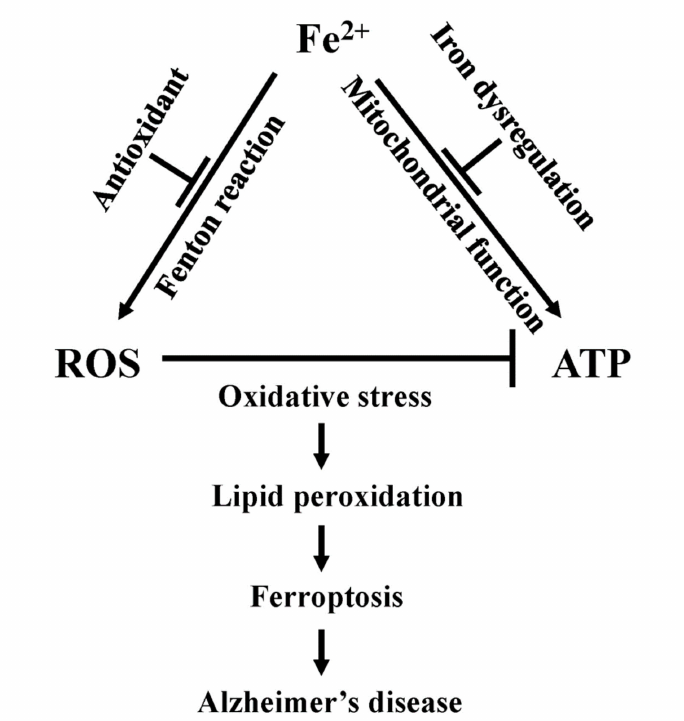
Figure 5. Ferroptosis, mitochondrial dysfunction and Alzheimer’s disease. Unbound Fe 2+ plays a role in ATP production via electron transfer and enzymatic reactions [12,14,16,75–77]. Fe 2+ dysregulation inhibits mitochondrial function resulting in decreased ATP production [37,67,68]. Fe 2+ is involved in ROS generation through the Fenton reaction [21,22,32,33] which is blocked by antioxidant [40–46]. ROS block ATP production via oxidative stress [20–22] that damages membrane lipids resulting in lipid peroxidation [70–74]. The accumulation of lipid peroxidation result in cell death known